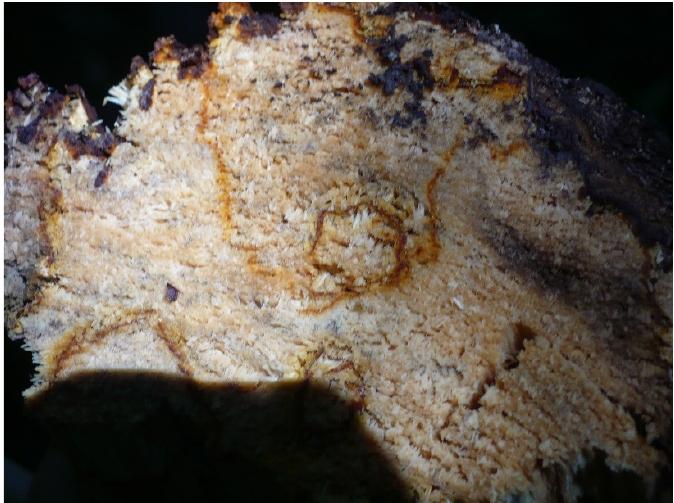
Figure 2. Specimen collected in the field station. The orange zone-lines made this a sample of